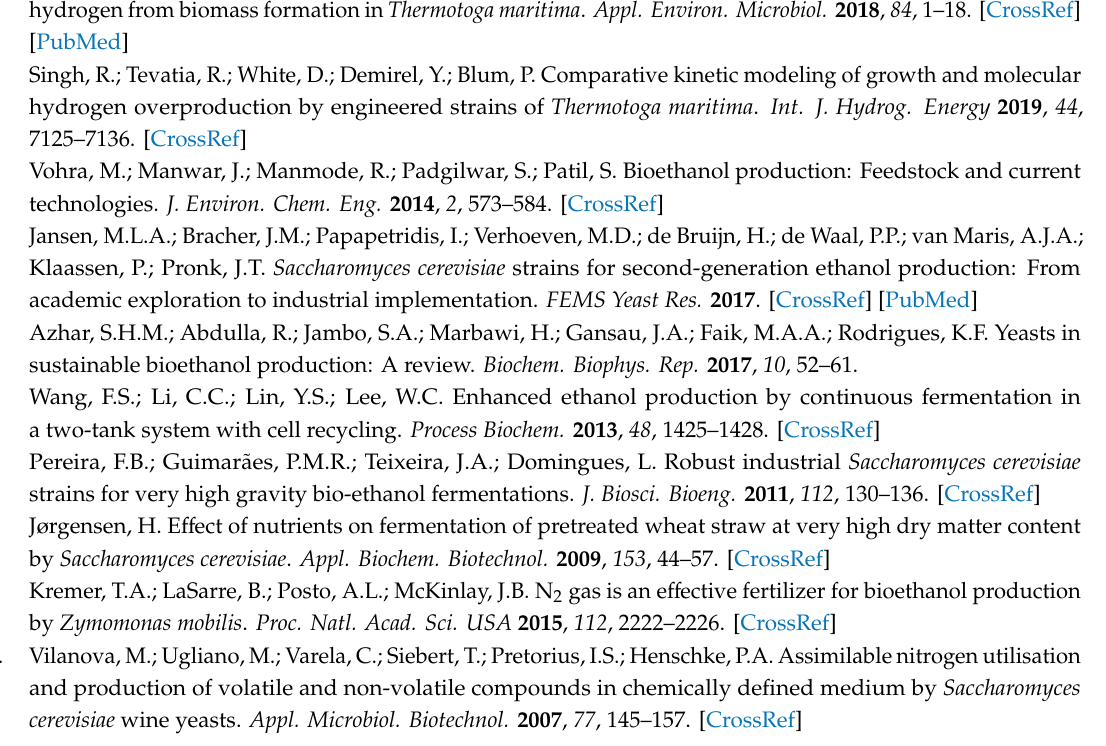
Table S1: Yeast strain screening